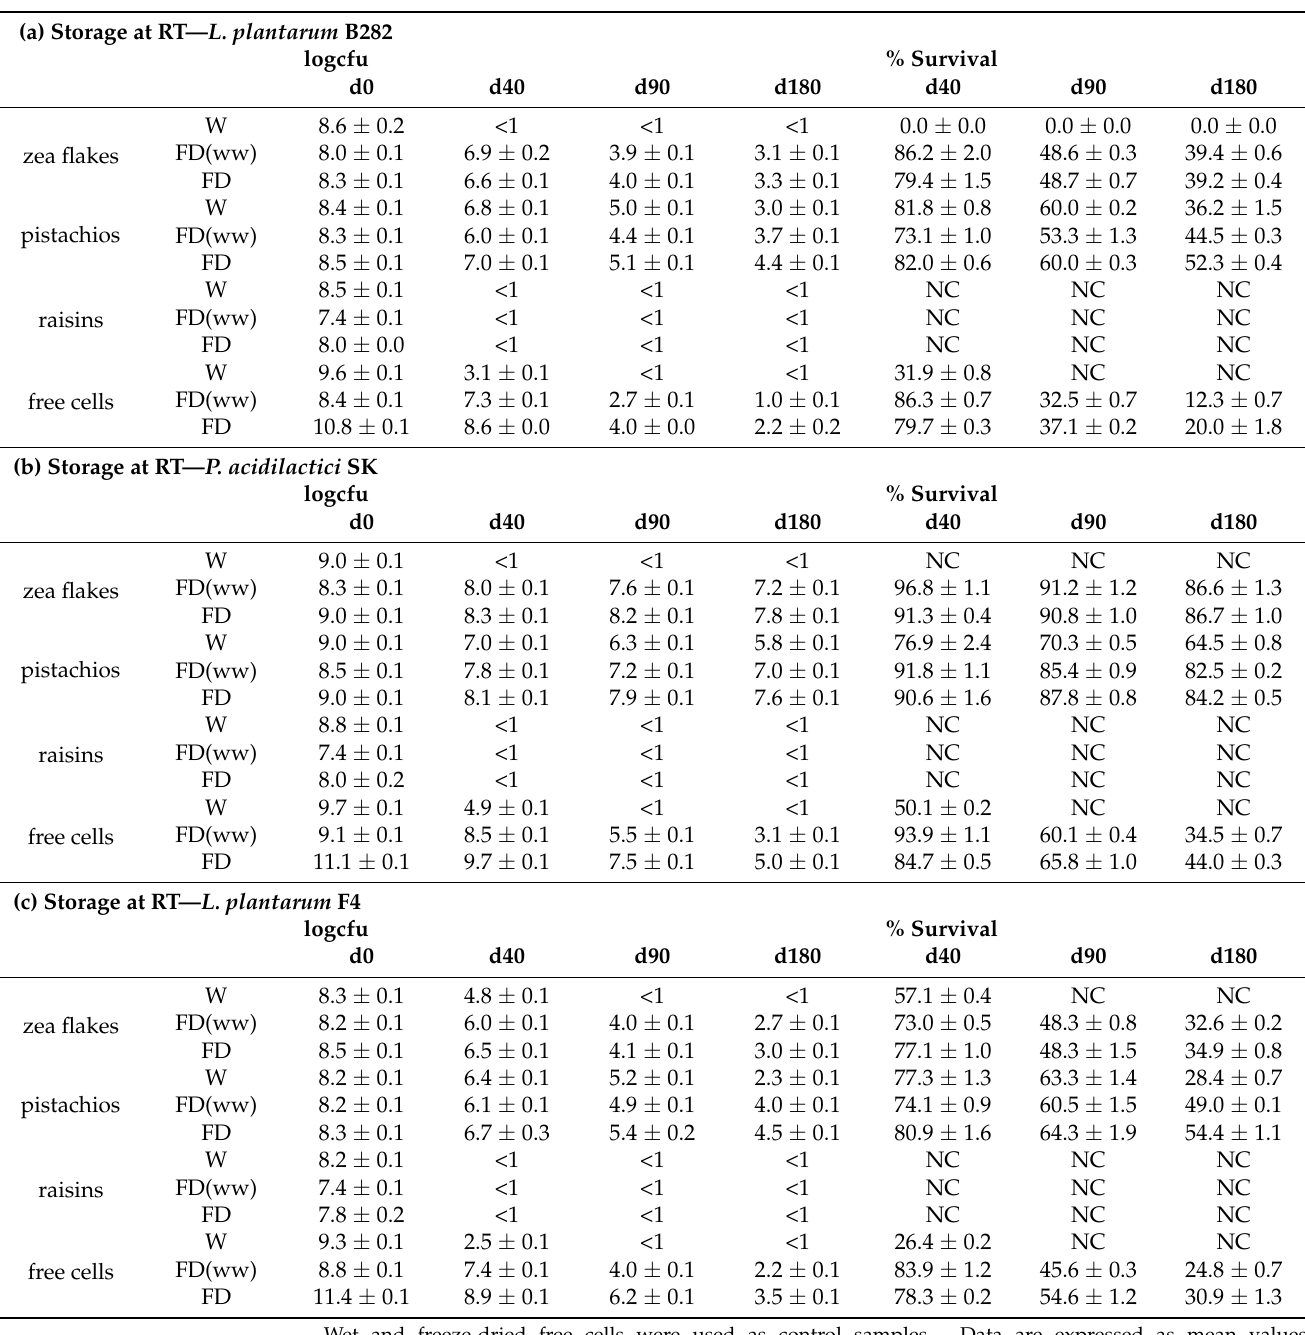
Table 2. ( a – c ) Effect of immobilization and storage at RT on cell levels and survival